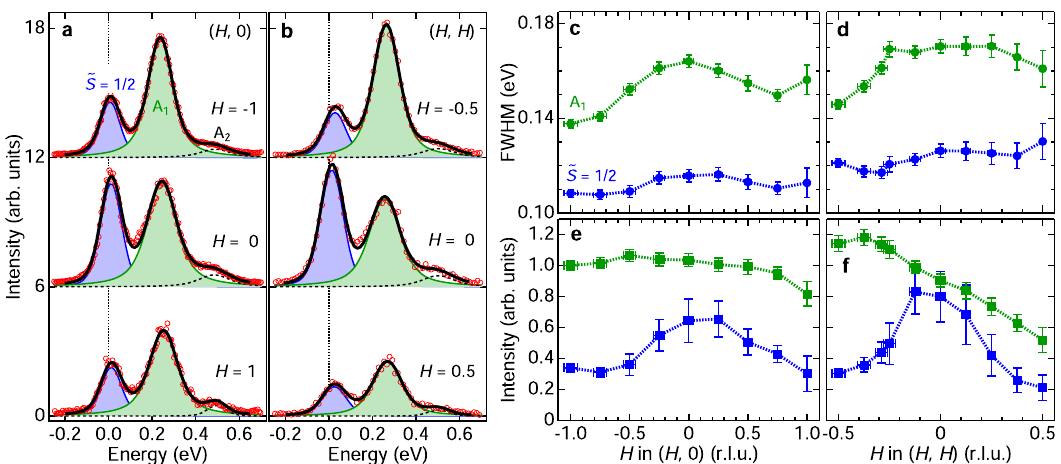
Fig. 4 FWHM and intensity of the A 1 peak and e S ¼ 1 = 2 excitations. a , b Ru L 3 RIXS spectra after the correction of x-ray self-absorption effect. The correction to the raw spectra was performed following the procedure in ref. 41 . The blue, green, and dashed black curves exemplify the spectral decomposition into three Voigt pro fi les representing the quasi-elastic peak, the e S ¼ 3 = 2 transitions (A 1 ), and the multi-excitons (A 2 ), respectively. The total fi tted curves are shown as thick black lines. c , d The full-width at half maximum (FWHM) of the quasi-elastic and the A 1 peaks as functions of q . e , f Momentum dependence of peak intensities along the q = ( H , 0) and ( H , H ) directions taken at T = 20